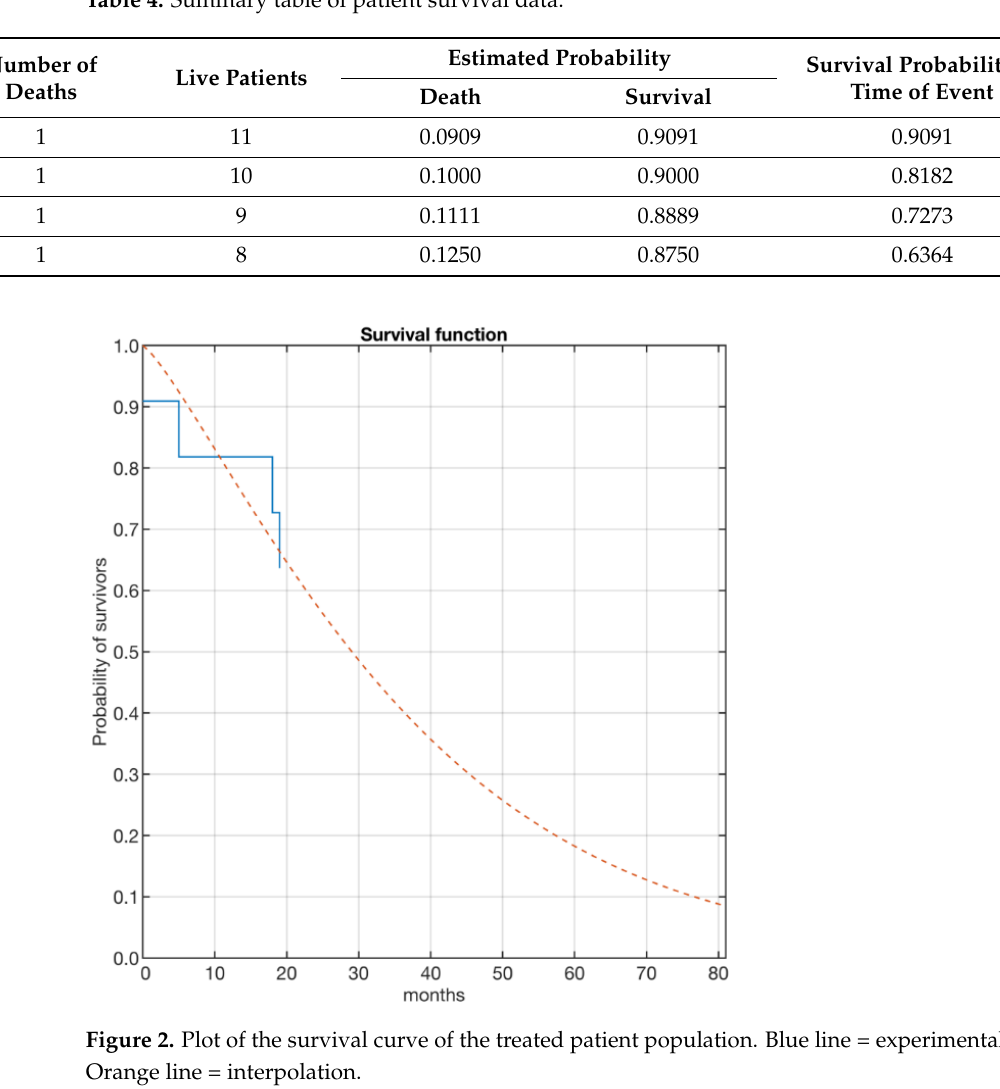
Table 4. Summary table of patient survival data.